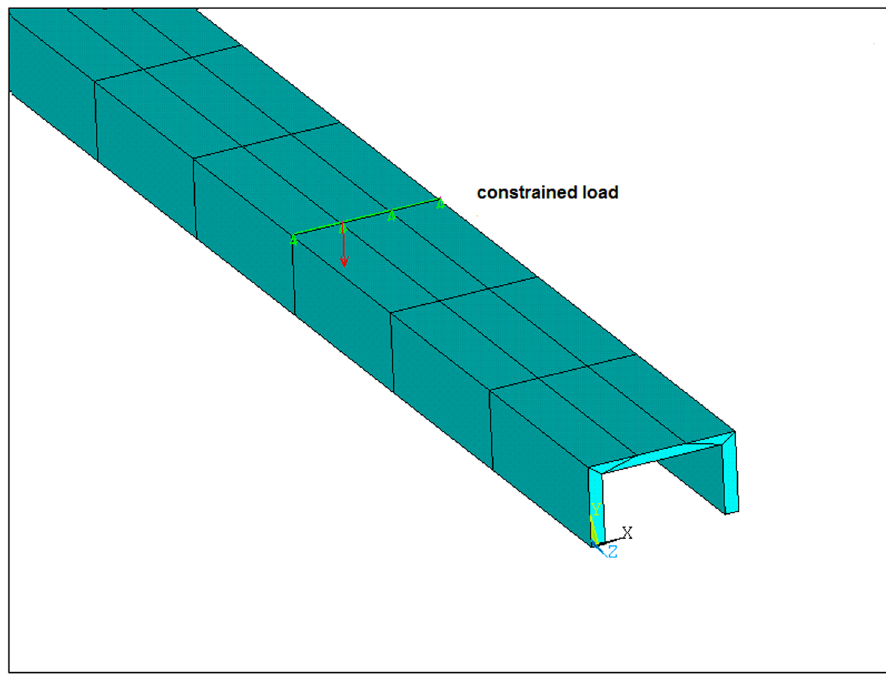
Figure 5: Point load is applied in FE